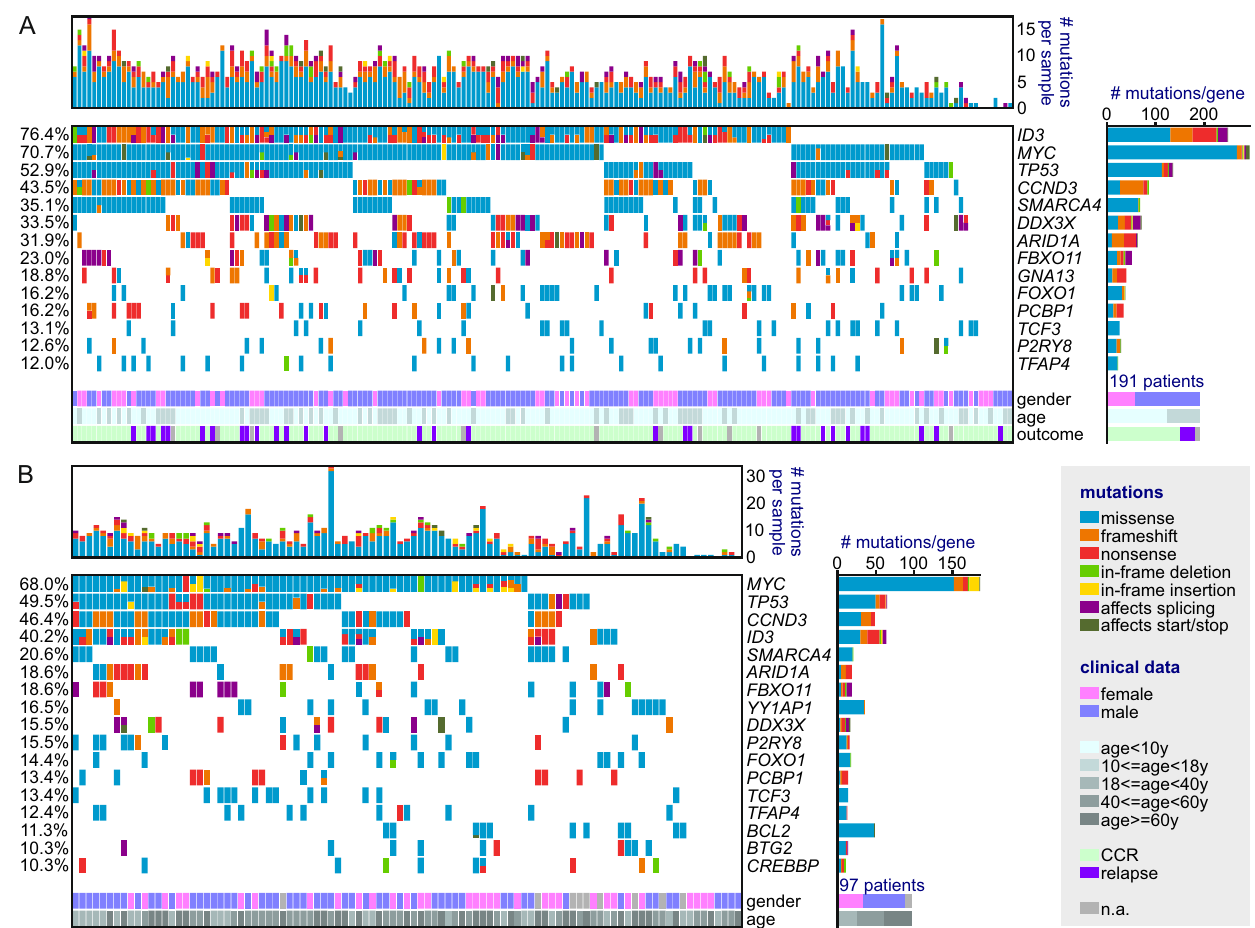
Fig. 1 Mutational landscape of pediatric and adult BL. In total, 191 pediatric and 97 adult patient samples were analyzed. Mutations with ≥ 10% cohort frequency are displayed. A In total, 14 recurrently mutated genes were found in the pediatric cohort, with ID3 being the most frequently altered gene. The color code indicates mutation types or clinical data classes (see legend). B In the adult cohort, 17 recurrently mutated genes were detected. In particular, YY1AP1 and BCL2 were unmutated or less frequently mutated in the pediatric